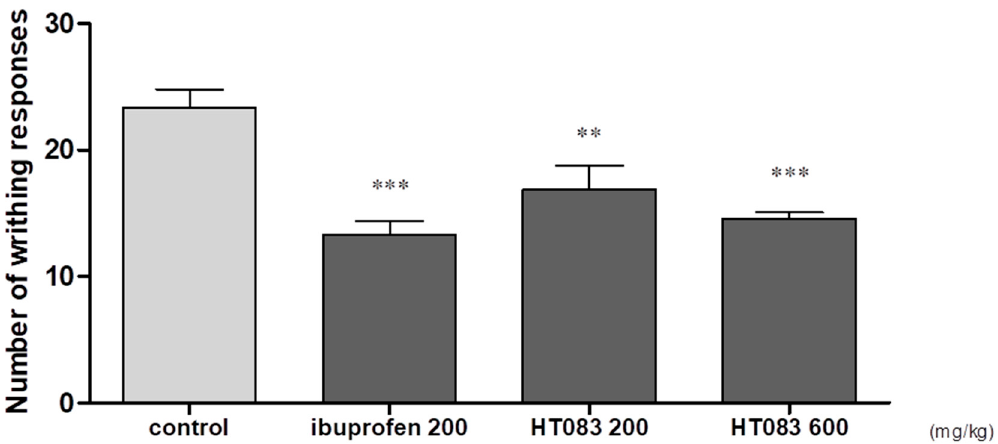
Figure 5. E ff ects of HT083 on acetic acid-induced writhing response in rat. The number of writhes was measured after 0.7% acetic acid injection for 10 min. Each value is the mean ± SEM. The number of animals is eight per group; ** p < 0.01 and *** p < 0.001 vs. control (one-way ANOVA, Dunnett’s post hoc test).